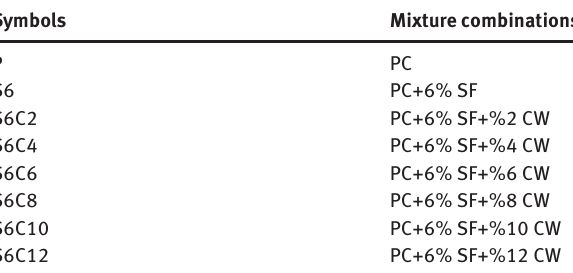
Table 5 Mixture proportions of cement mortars. Symbols